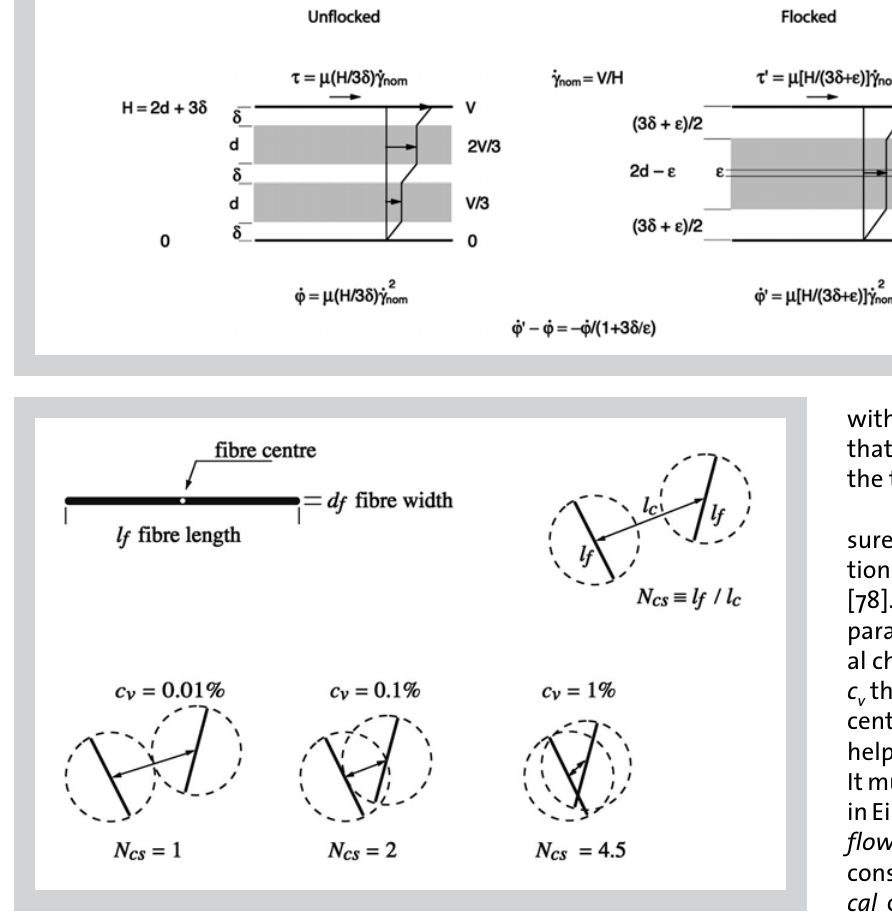
Figure A1 (above): Thermodynamic floccula- tion forces. Figure A2: The fibre centre span N defined as the ratio between the fibre length lf and the distance between neighbouring fibre centres l when the fibre centres are distributed evenly in space, i.e. rhombohedrally. Three examples with aspect ratios r = 100 are